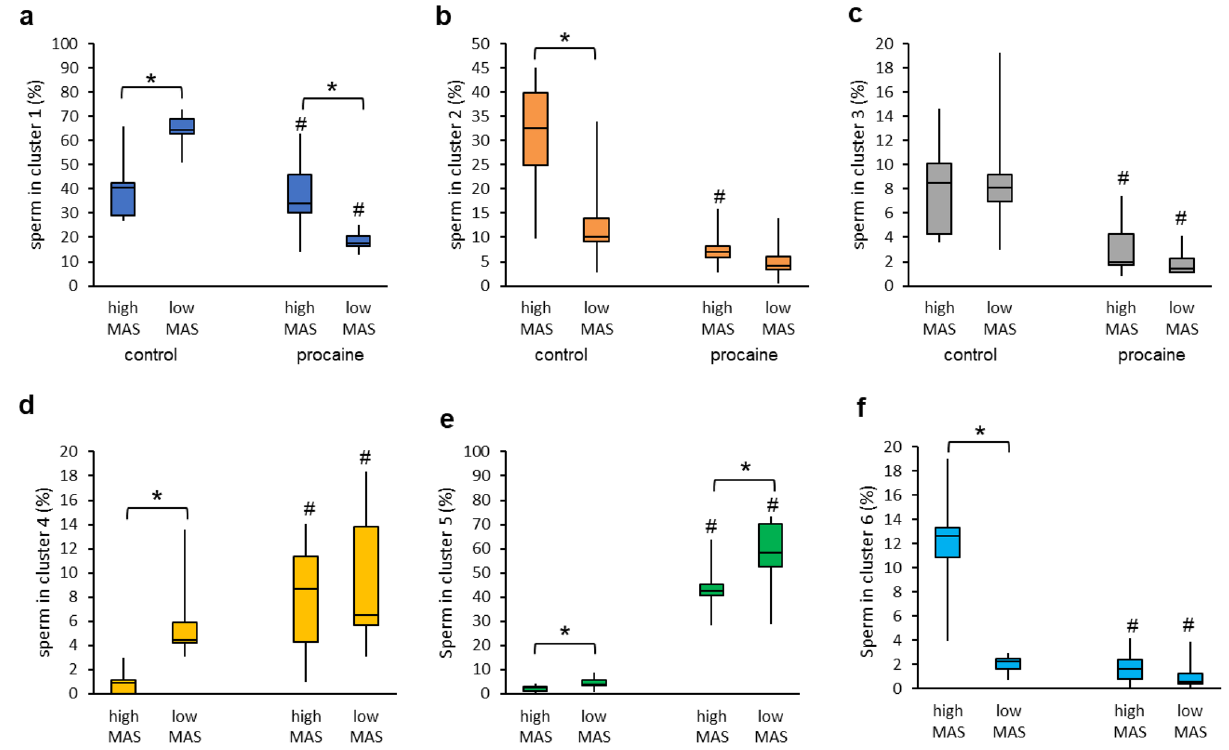
Figure 5. Impact of procaine on motility patterns of morphologically normal spermatozoa originating from extended semen samples with either enhanced (≥ 15% = high MAS; n = 10 boars) or low (< 5% = low MAS; n = 9 boars) prevalence of sperm with cytoplasmic droplets and/or bent tails. Extended semen samples were centrifuged, and pelleted sperm incubated in non-capacitating Tyrode’s medium without (control) or with 7.3 mM procaine for 10 min at 38 °C. Graphs ( a ) to ( f ) show the six major sperm subpopulations as described in Fig. 4. Boxes show the interquartile range. Vertical lines indicate minimum and maximum, while the horizontal line in the box indicates the median. An asterisk (*) indicates a significant difference between high MAS and low MAS samples ( p < 0.05). A hash (#) indicates a significant difference between the sample treated with procaine and the respective control ( p <